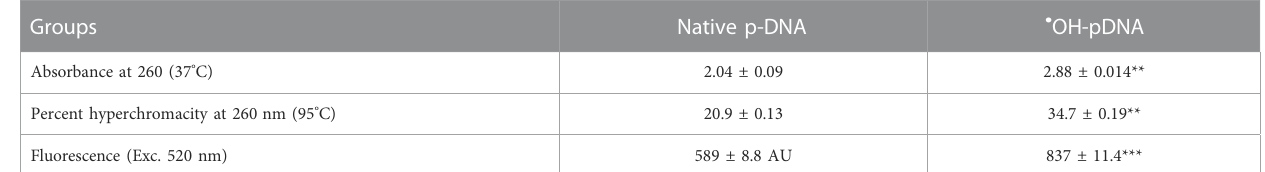
TABLE 3 Characterization of hydroxyl radical modi fi ed plasmid DNA. Groups